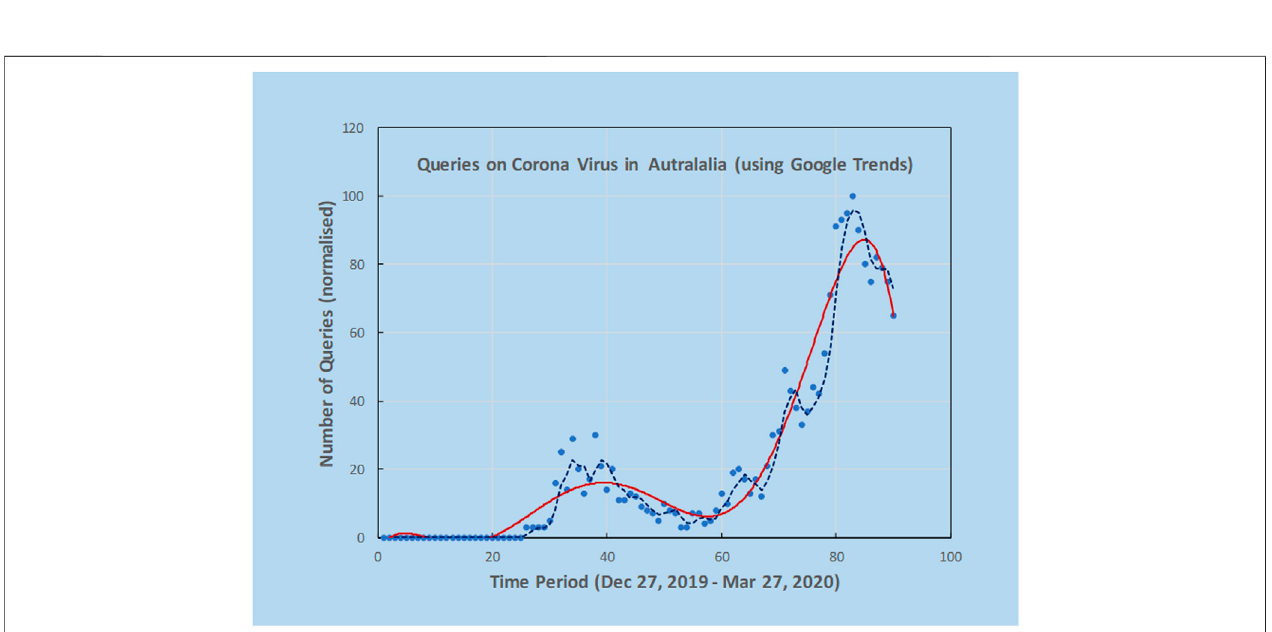
FIGURE 2 | Using Google Trends, it was possible to investigate online search activity over a period of three months using the keywords “ Corona Virus Australia ” . Solid line is an estimate of trend by fi tting a polynomial curve to the scatterplot data from Google Trends and the dashed line is 3-point moving average. Peaks indicate high interest at certain dates that could be correlated with news reports. Note the double peak in query dates.